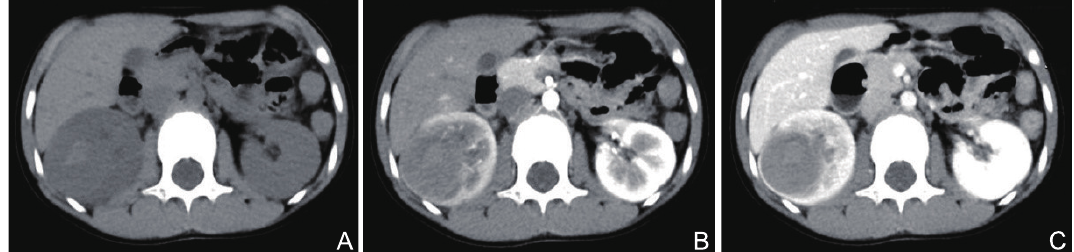
Figure 4 The CTU. (A) CT plain scan showed there was a round-like mass with mixed density in the central and inferior pole of the right kidney. (B~C) The enhanced CT scan. The mass showed the slight heterogeneous enhancement and lack of enhancement in loculi inside it. The enhancement was less than the renal